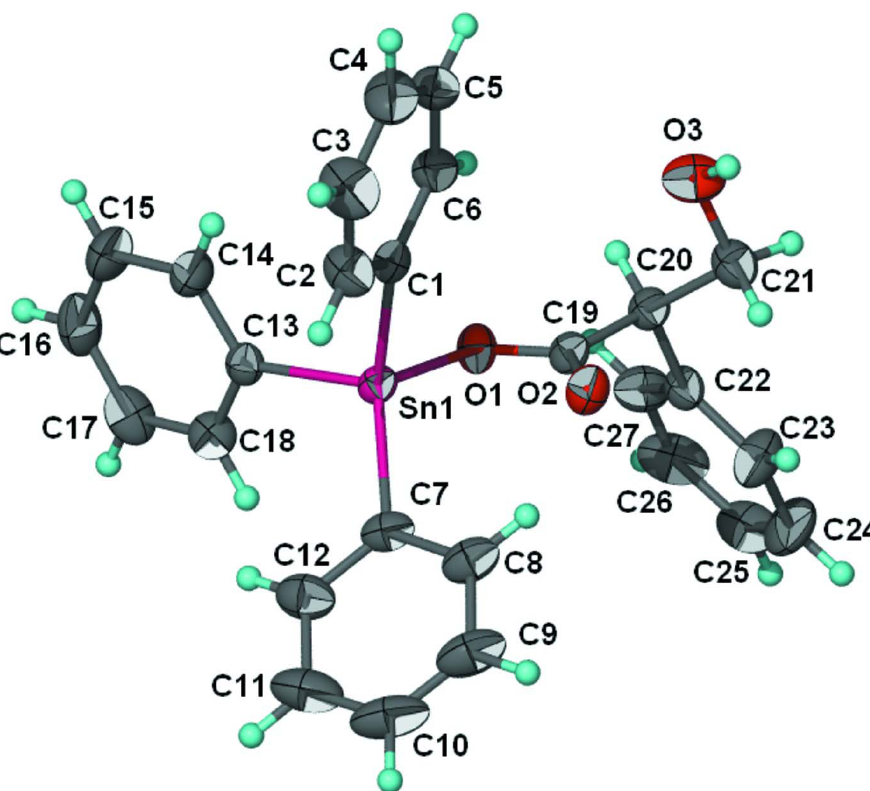
The molecular structure of (I) showing displacement ellipsoids at the 70% probability level; hydrogen atoms are shown as spheres of arbitrary